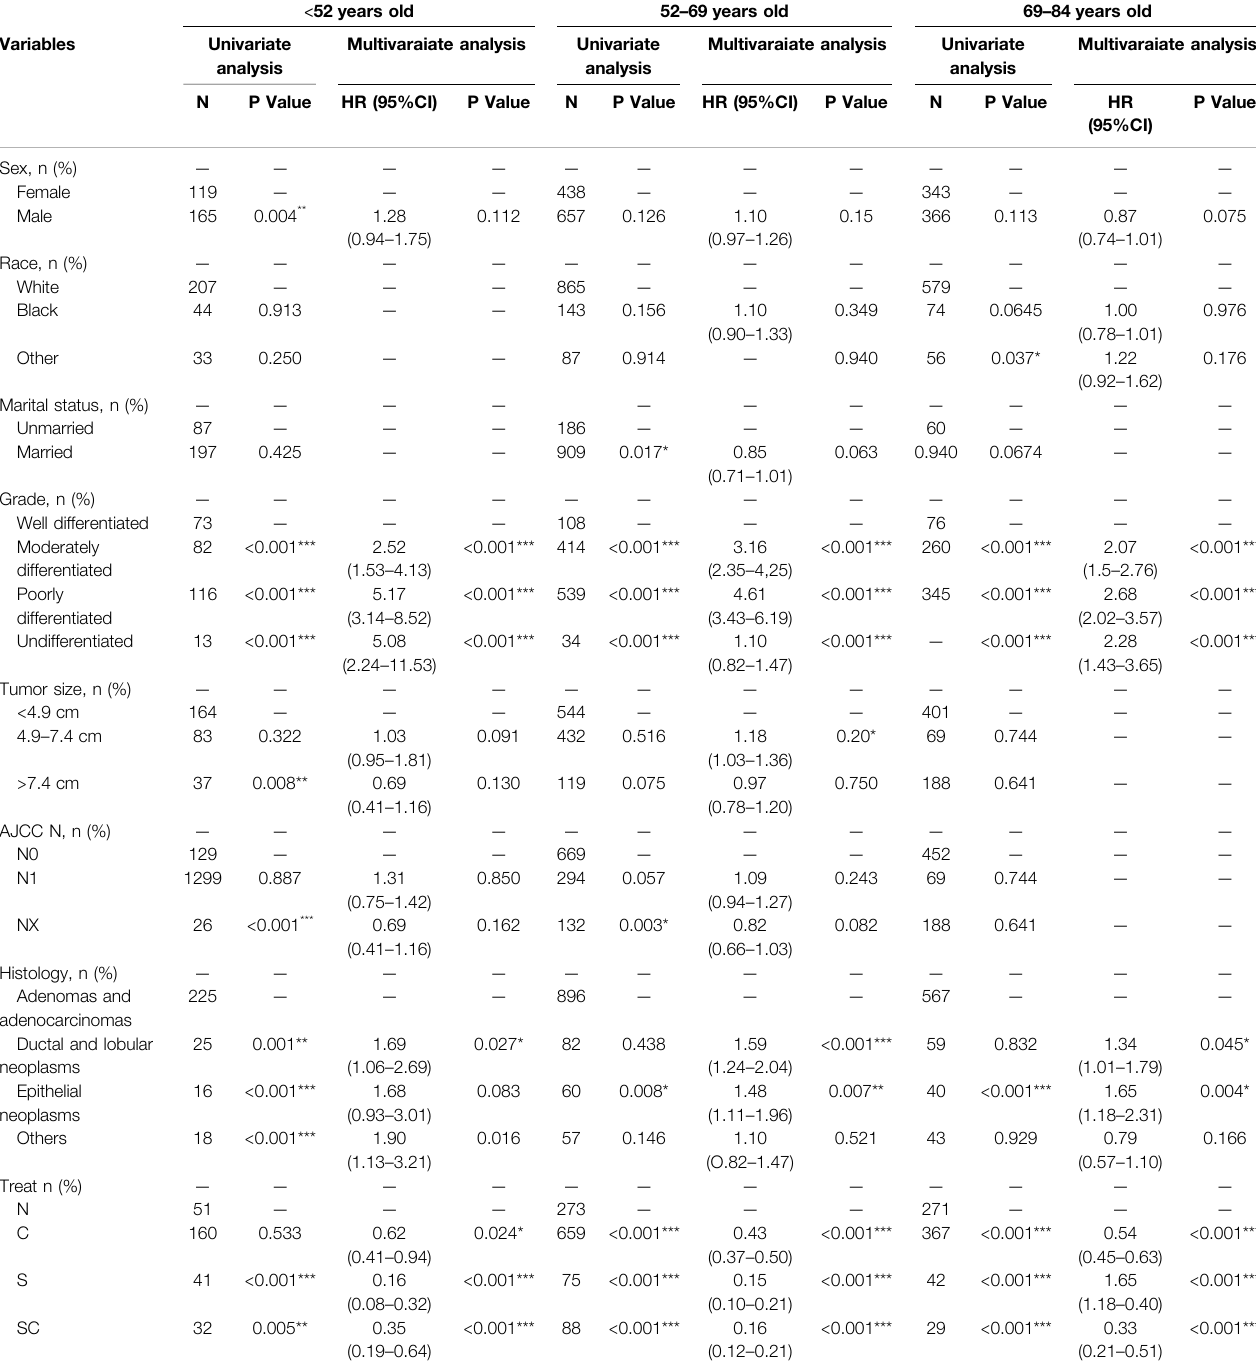
TABLE 3 | Univariate and multivariate of OS in the patients with pancreatic cancer metastasis to liver grouped by age at diagnosis. < 52 years old 52 – 69 years old 69 – 84 years